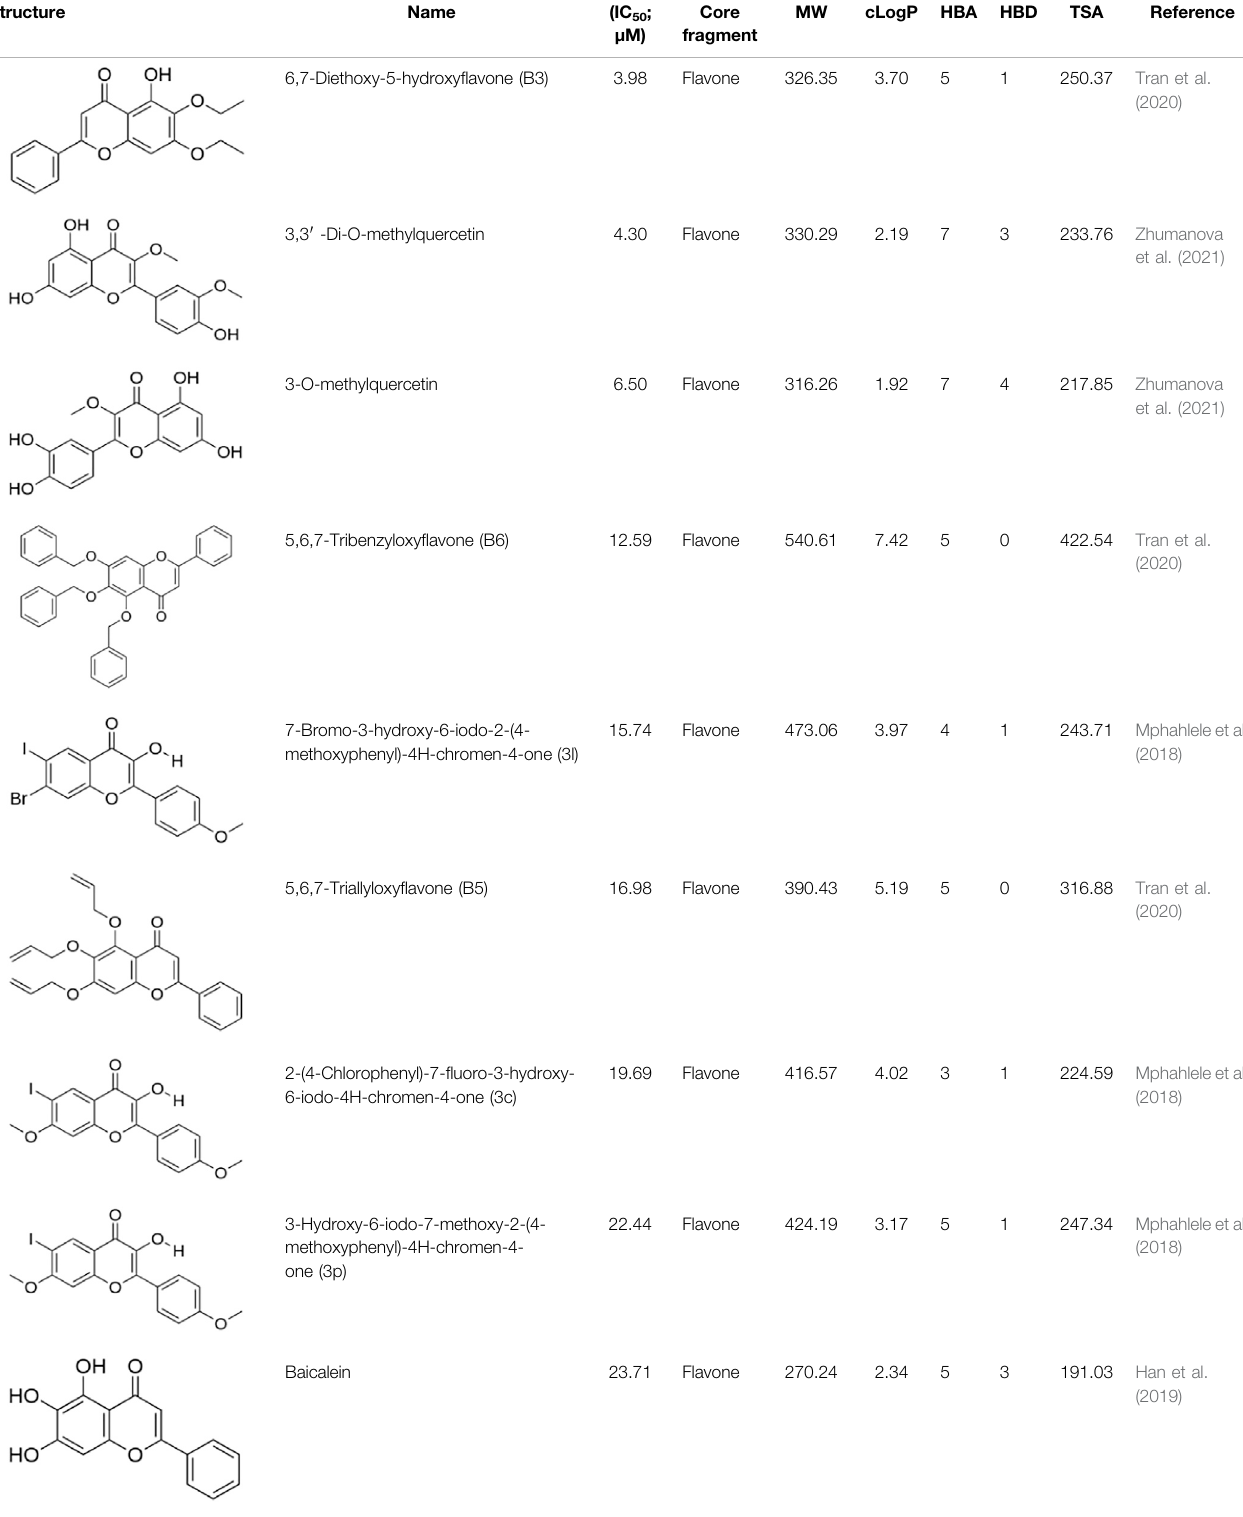
TABLE 3 | ( Continued ) Information of the 64 fl avonoid compounds that were fi ltered and classi fi ed according to their